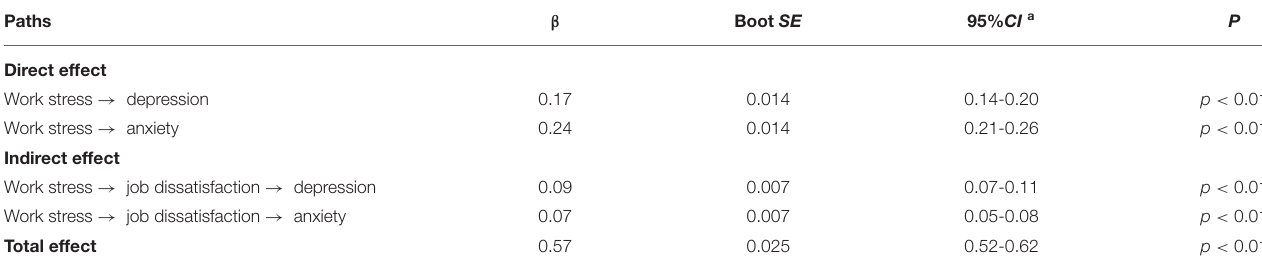
TABLE 4 | Bootstrap analyses of total, direct, and indirect effects of the mediation model.